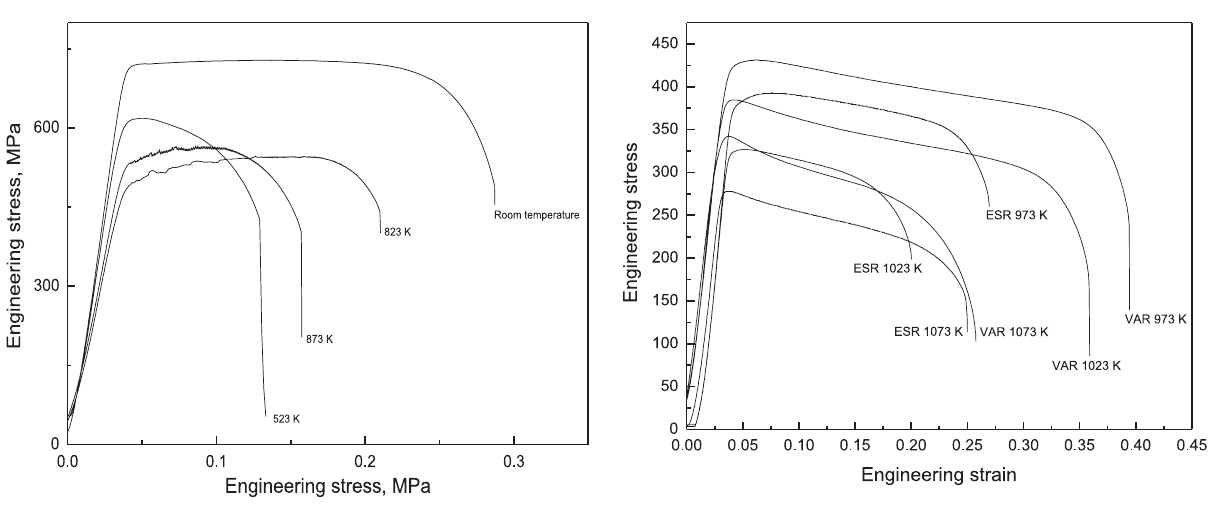
Fig. 4: Typical curves in the DRX regime of ESR and VAR stainless